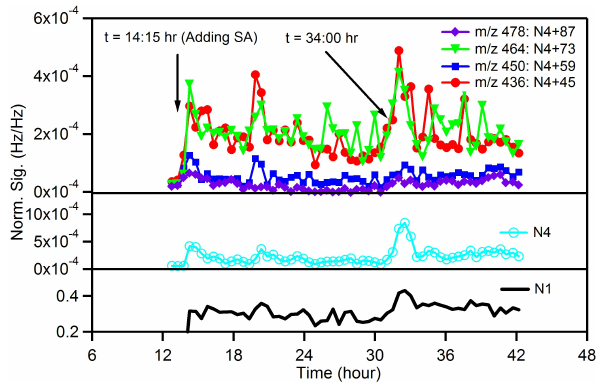
Fig. 4. Temporal profile of the sulfuric acid-amine clusters during the experiment period of 18 June–19 June 2010 (setting 00:00a.m. local US mountain time 18 June as 0h), along with sulfuric acid tetramer (N4) and monomers (N1), measured at the Foothills labo- ratory of NCAR in Boulder, Colorado. Intensities of all the signals were divided by sum of intensities of reagent ions (i.e. m/z 125 and